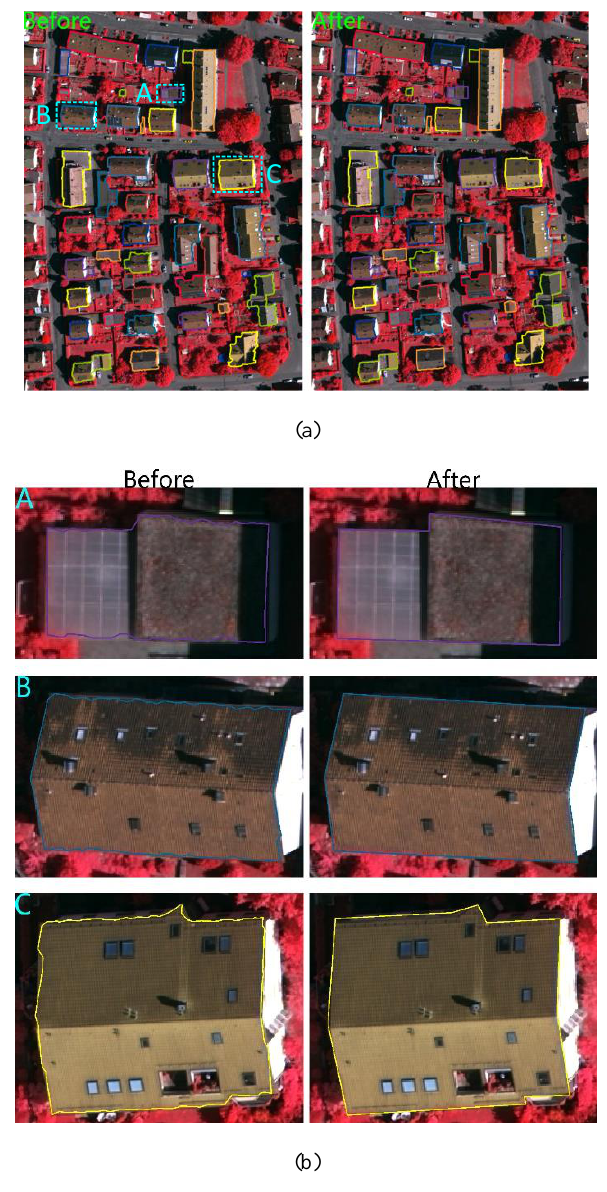
Figure 9. The results of building contour refinement of Area